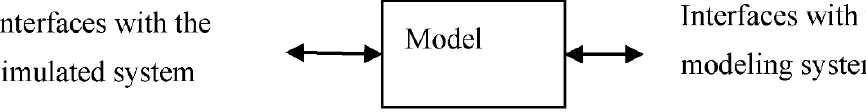
Figure 9. DDTM hierarchy.